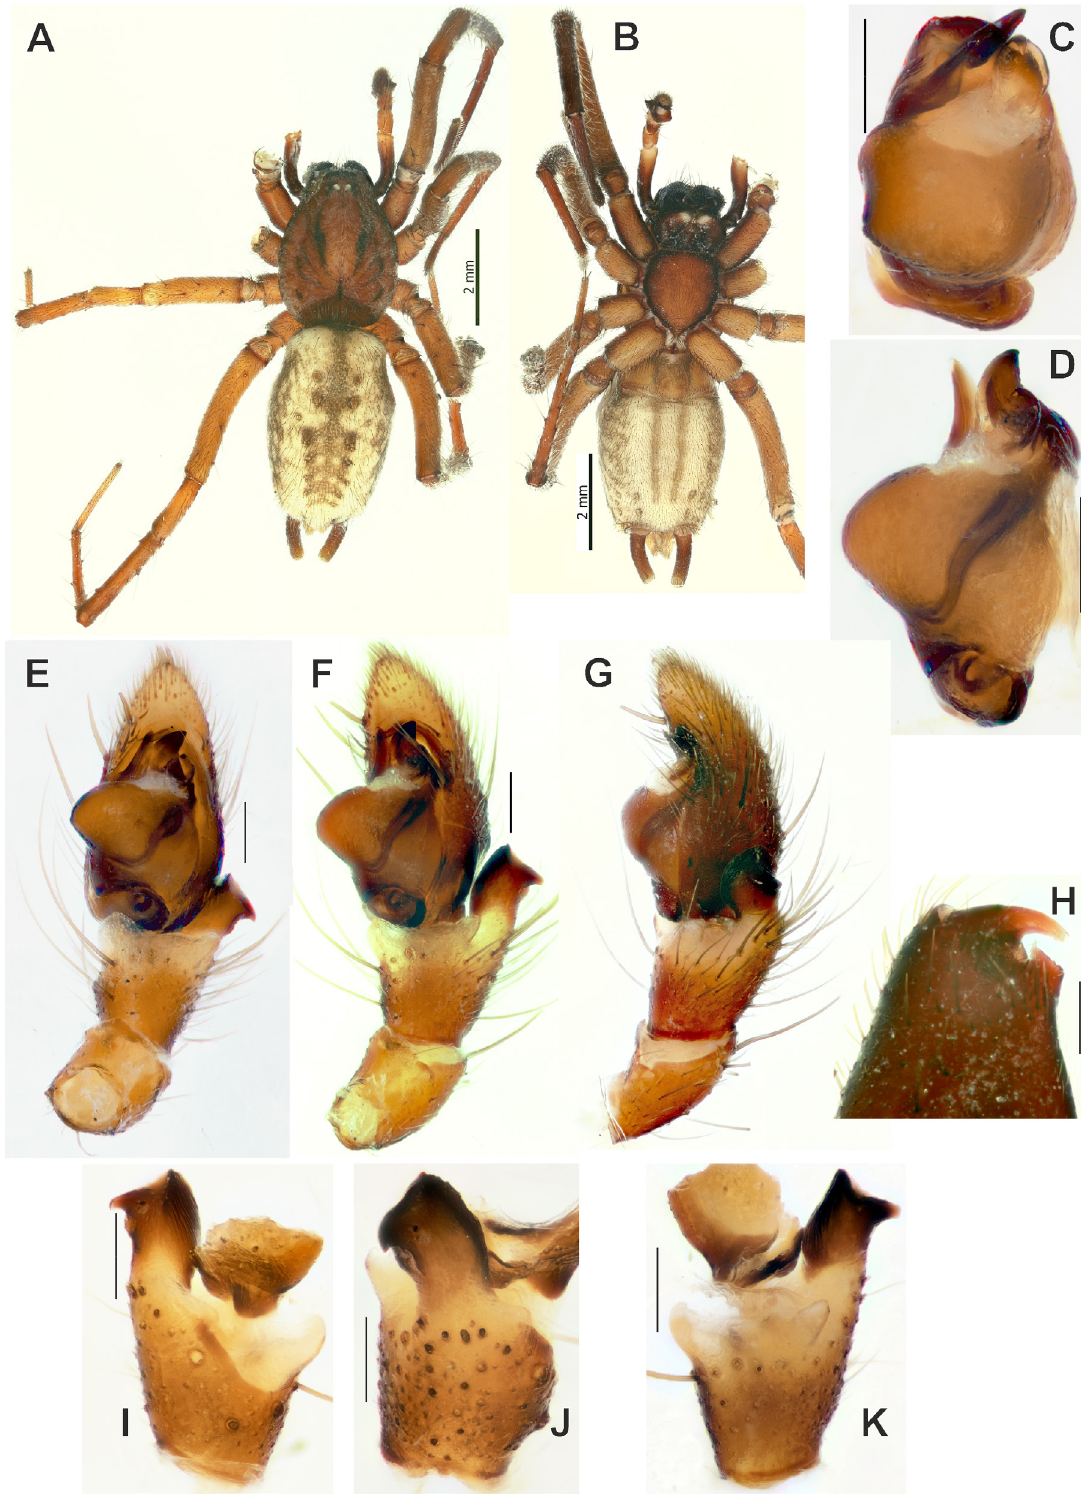
Fig. 17. Nomisia ameretatae sp. nov., holotype, ♂ (MMUE). A–B . Habitus, dorsal and ventral views. C–D . Bulb, dorsal and retrolateral views. E–G . Palp, ventral, retroventral and retrolateral views. H . Chelicera, posterior view. I–K . Tibial apophysis, dorsal, retrolateral and ventral views. Scale bars: 0.2 mm, unless stated